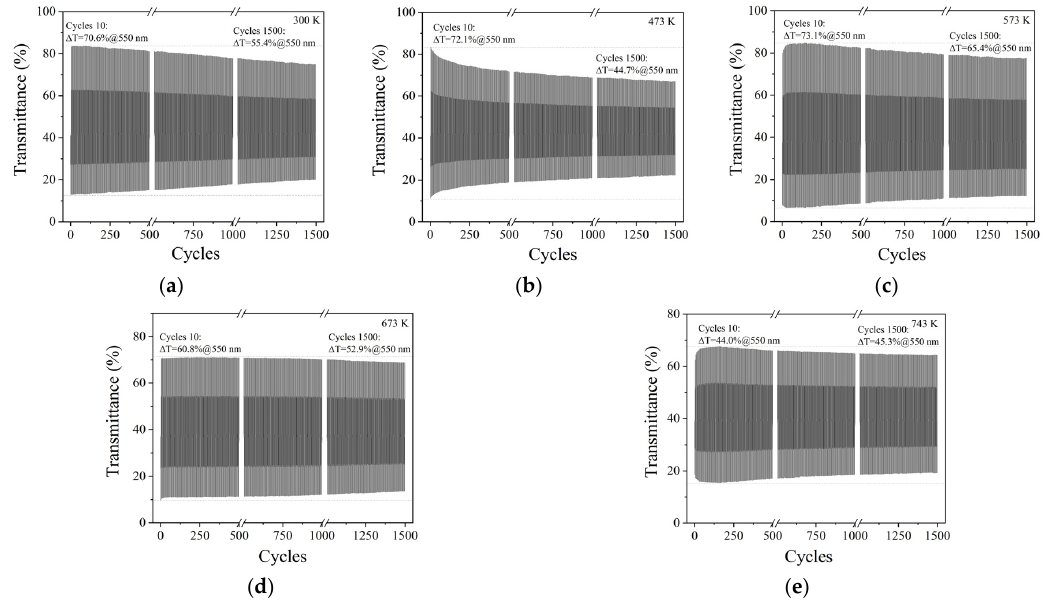
Figure 8. The transmistance curve of WO 3 film after 1500 cycles deposited at different substrate temperatures: ( a ) 300 K, ( b ) 473 K, (c) 573 K, ( d ) 673 K and ( e ) 743 Table 1. Electrochromic index various parameter of WO 3 films deposited at different substrate temperatures .